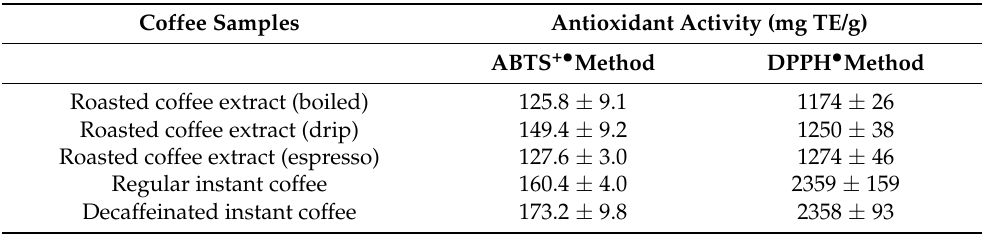
Figure 4. Free-radical scavenging activity of roasted coffee extracts and instant coffee. ( A ) ABTS + • solution was incubated with deionized water (DI), standard Trolox, boiled, drip and espresso roasted coffee extracts, as well as regular and decaffeinated instant coffee products, while optical density (OD) was photometrically measured at a wavelength of 764 nm against the reagent blank. ( B ) DPPH • solution was incubated at various concentrations of standard Trolox, boiled, drip and espresso coffee extracts, regular and decaffeinated instant coffee products and OD was photometrically measured at a wavelength of 517 nm against the reagent blank. Radical-scavenging activity was calculated according to the method described in Section 4.7 and is reported as percentage of ABTS + • or DPPH • scavenging activity. Data obtained from three repetitions are expressed as mean ± SD values. Table 5. Antioxidant activity values of coffee samples accessed using ABTS + • and DPPH •